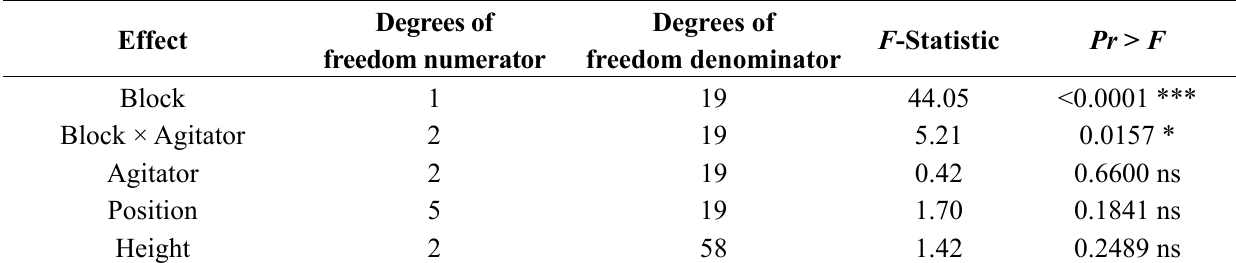
Table 2. Type 3 tests of fixed effects of DM content on the reduced model. Effect